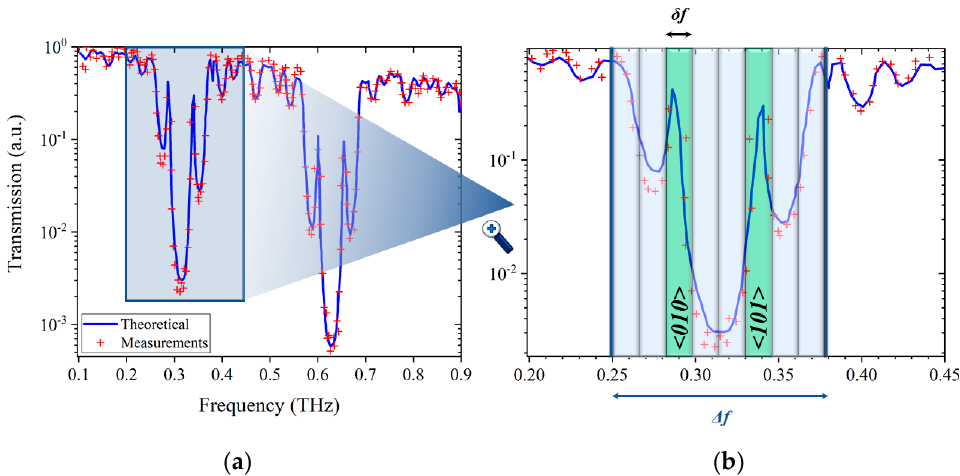
Figure 3. ( a ) Experimental (blue circles) and calculated (black continuous line) transmission spec-tra of the tag presented in Figure 1b. Focused on the first PBG whose limits are defined by blue vertical lines. Vertical strips represent the frequency coding channels. © 2021 IEEE: Figure ( b ) is plotted from [24].